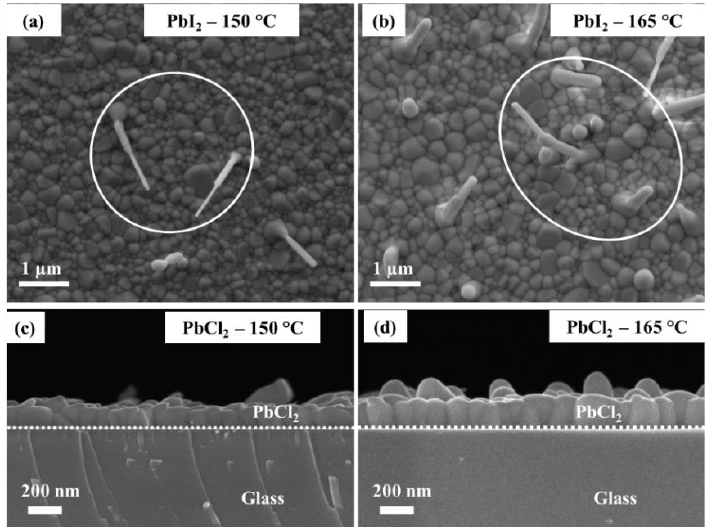
Figure 6. Planar SEM micrographs of the two PbCl 2 thin films deposited at different substrate temperatures: ( a ) 150 and ( b ) 165 °C, as shown on the micrographs; ( c , d ) cross-sectional SEM micrographs of the PbCl 2 films deposited at different substrate temperatures as shown.